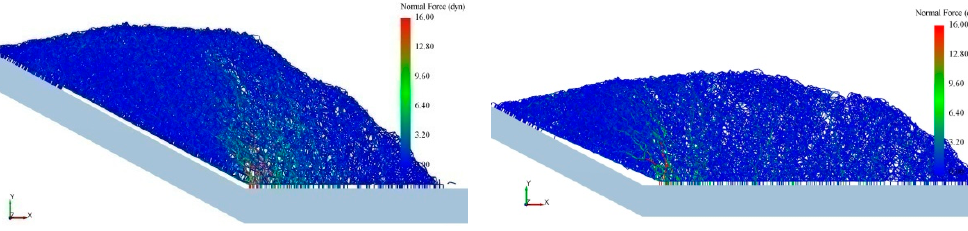
Figure 11. Diagram of normal force of wet soil sliding at the slope foot ( γ = 0.1 J/m 2 , d = 0.7 mm).